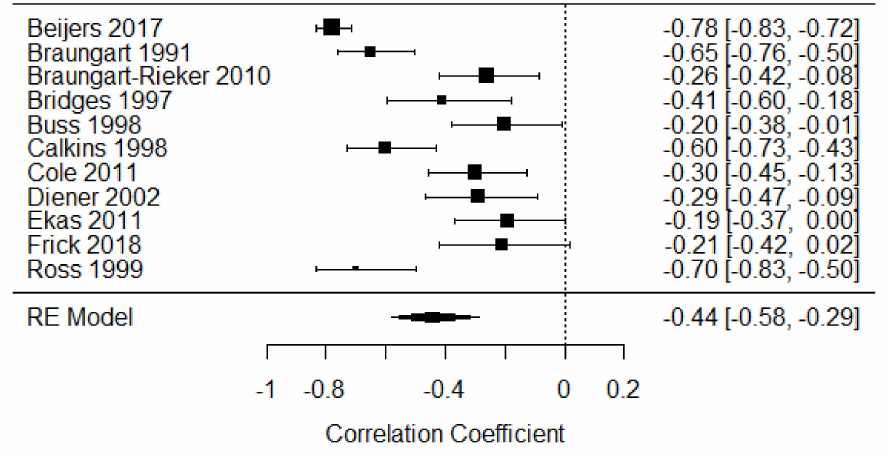
Figure 4. Forest plot of year 2 disengagement of attention. Note: RE = Random-Effects Model. Third Year of